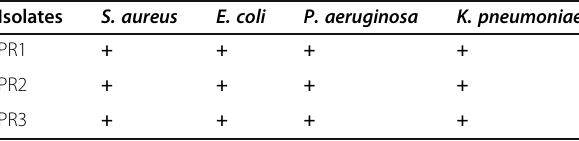
Table 2 Antibacterial activity against pathogenic bacteria by primary screening